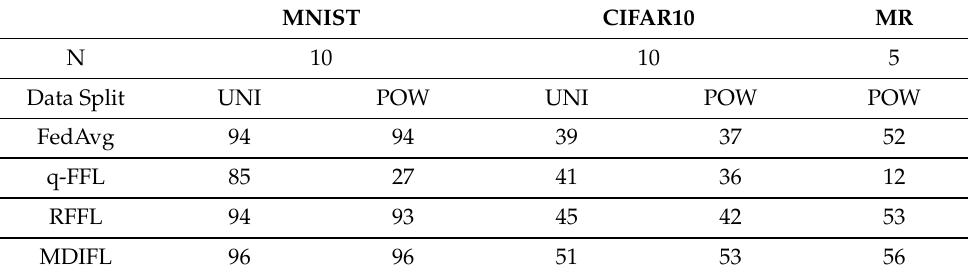
Table 2. Maximum accuracy (%) including S_P in different situations.